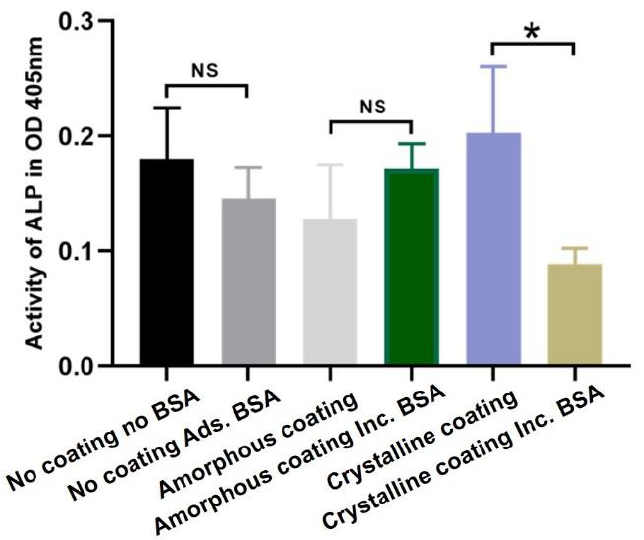
Figure 5. Graph depicting relative alkaline phosphatase (ALP) activity in primary osteoblasts after 8 days of culture in different groups. Mean values (n = 3 for each group) were presented together with the standard deviation (* p < 0.05, NS p >